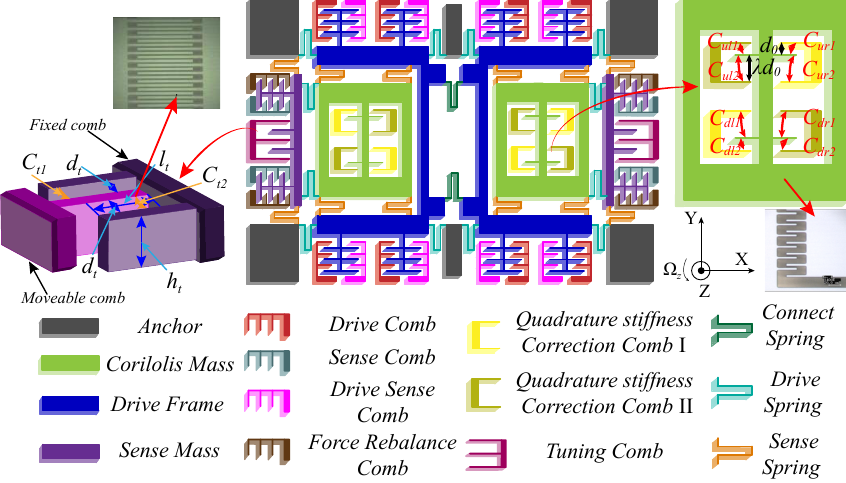
Figure 1. Mechanical model of dual-mass MEMS